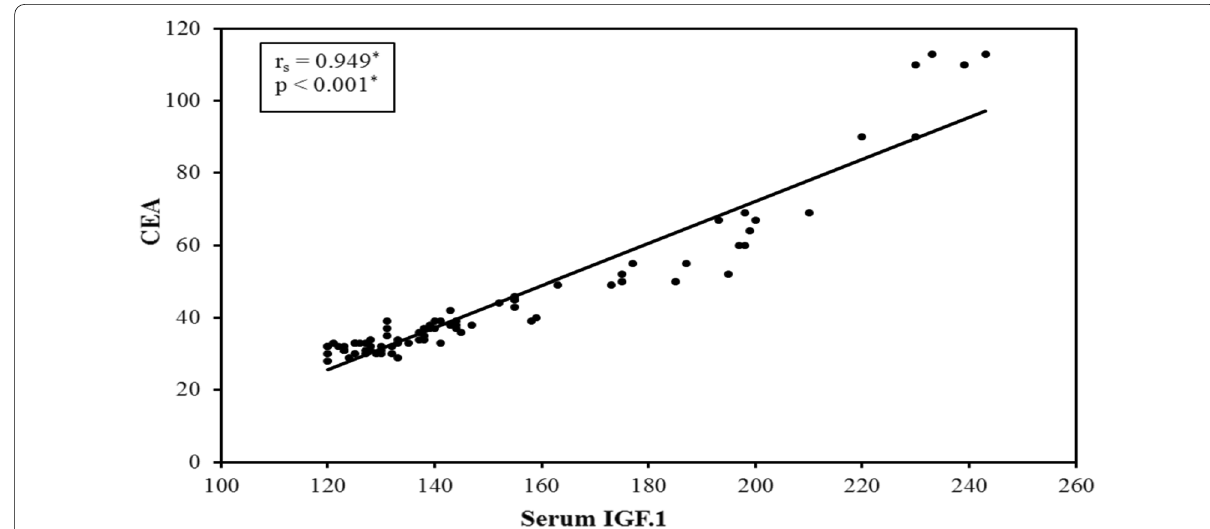
Fig. 6 Correlation between IGF rs6214 with CEA in colorectal Cancer group ( n